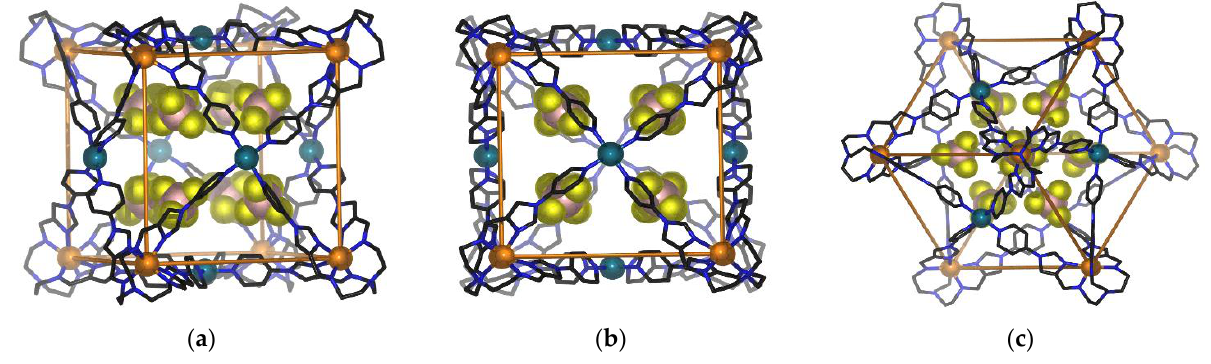
Figure 5. Schematic representation of the same view shown three ways for the single crystal X-ray